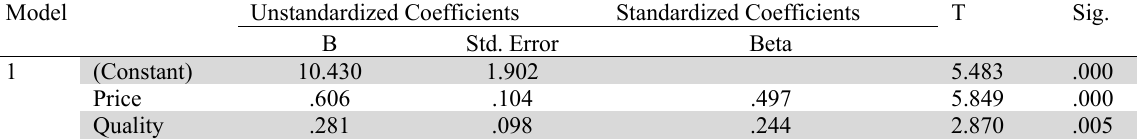
Model 2 Multiple Linear Regression Test Results (Coefficients a ) Model Unstandardized Coefficients Standardized